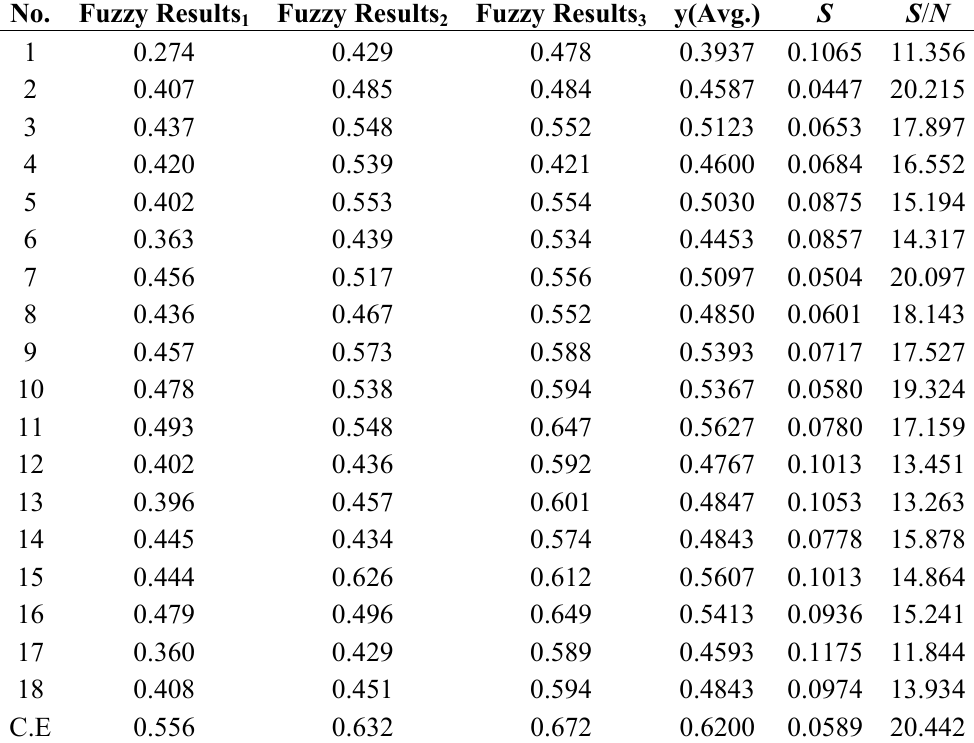
Table 9. Measured results for the L